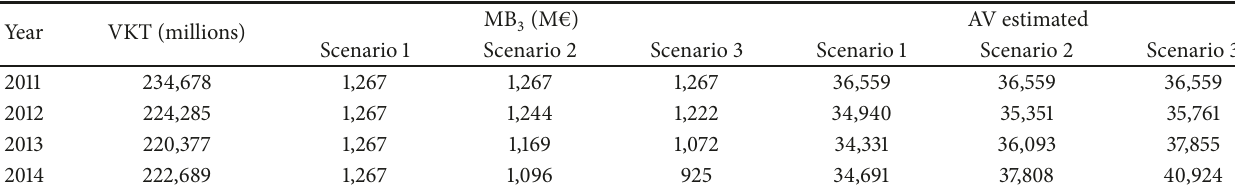
Figure 6: Relationship between Risk Index and Average Values of Road Budgets (3 preceding years). Table 3: Estimated value of AV with higher conservation budgets.